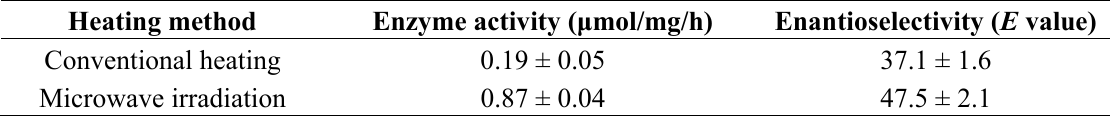
Table 1. Comparison of the enzymatic resolution of ibuprofen heated by microwave irradiation and conventional heating a